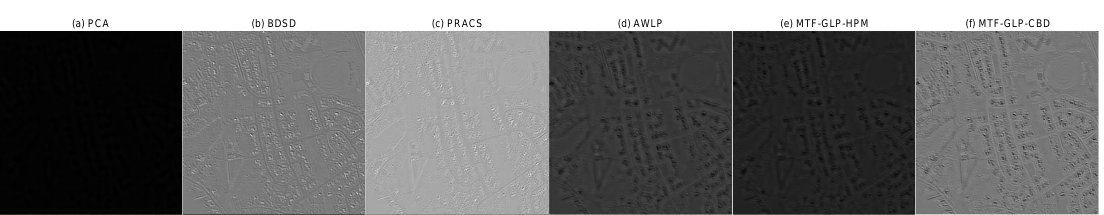
Figure 9. Visualization of weight maps on the GeoEye-1 images, ( a ) PCA; ( b ) BDSD; ( c ) PRACS;